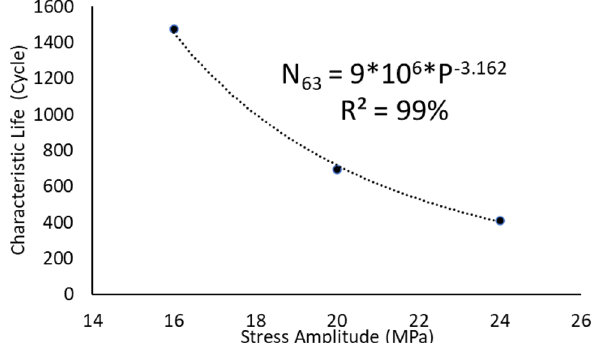
Figure 4. The Stress life equation for SAC305 solder joints that were cycled at room temperature.